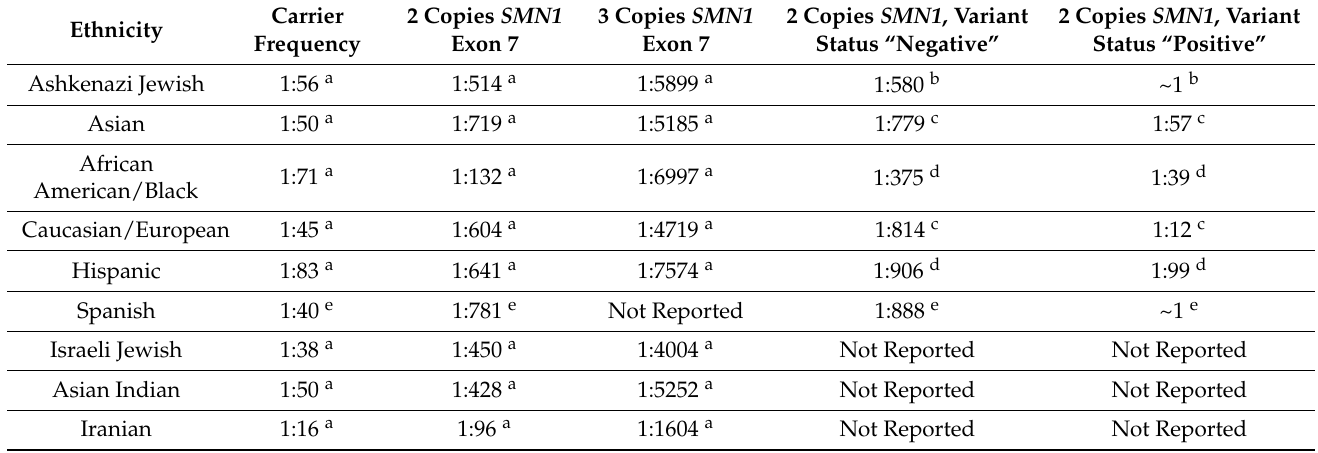
Table 1. Residual SMA carrier risk estimates by ethnicity based on SMN1 copy number and gene duplication variant status. Carrier frequency represents carrier risk without testing by ethnicity. Subsequent columns estimate residual risk based on SMN1 copy number alone. The last two columns estimate the residual risk with two copies of SMN1 with additional information on the presence of SMN1 gene duplication variants ( SMN1 c.*3+80T>G and c.*211_*212del), where “positive” indicates presence of one or both variants, and “negative” indicates absence of both variants. Values are rounded to the nearest integer. Asian includes groups with South Asian and East Asian